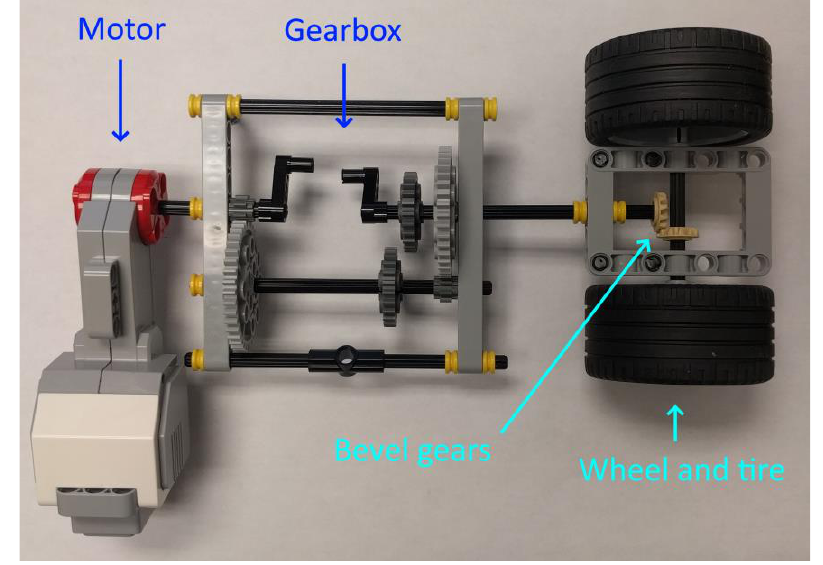
Fig. 3. An example of a gearbox as a mechanical engineering